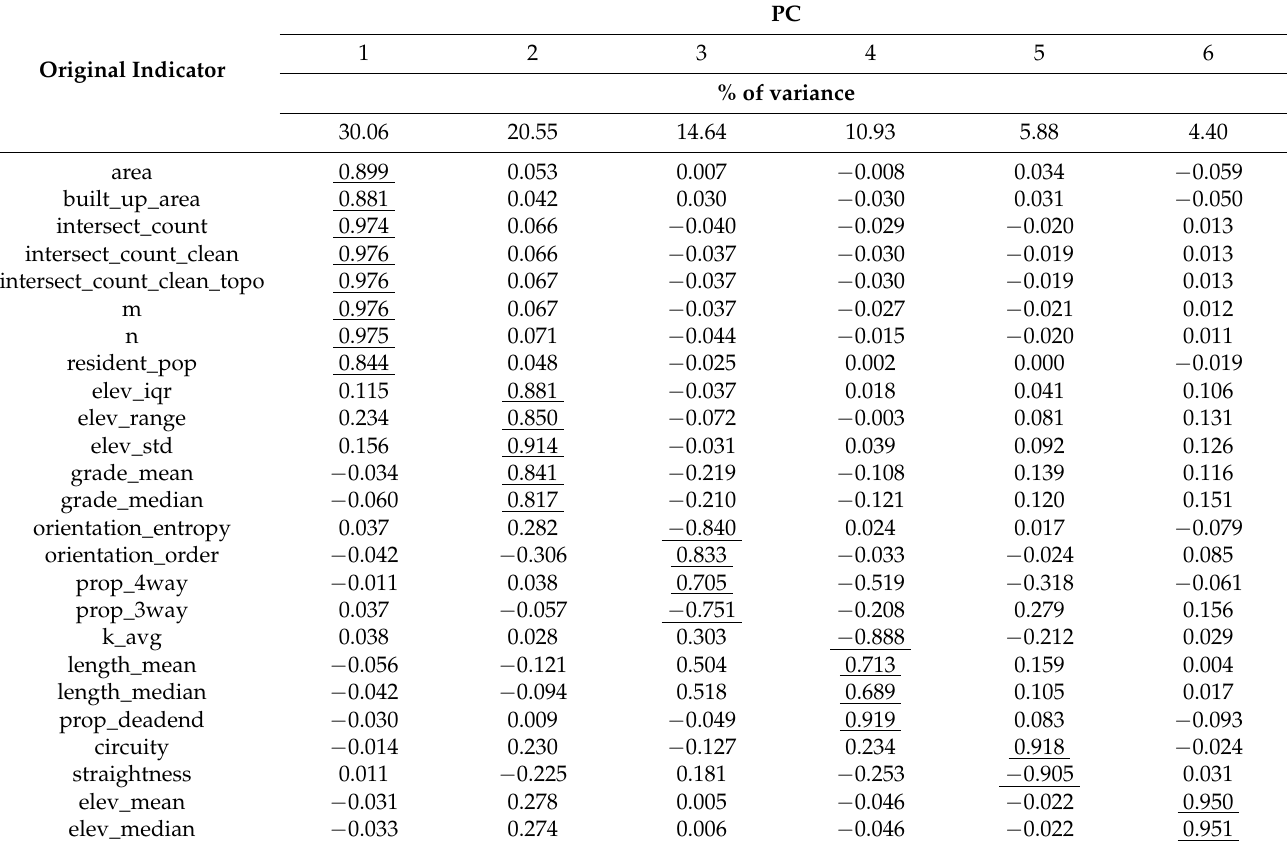
Table 3. Correlations between each of 6 PCs and the original 25